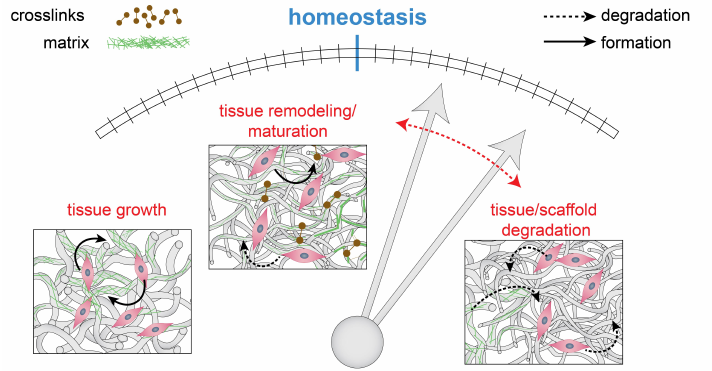
Figure 3. Mechanical homeostasis is a delicate balance between tissue growth, degradation, and remodeling. A perturbation of the equilibrium will result in a relative upregulation of one of these processes (indicated in red), in an attempt to restore the